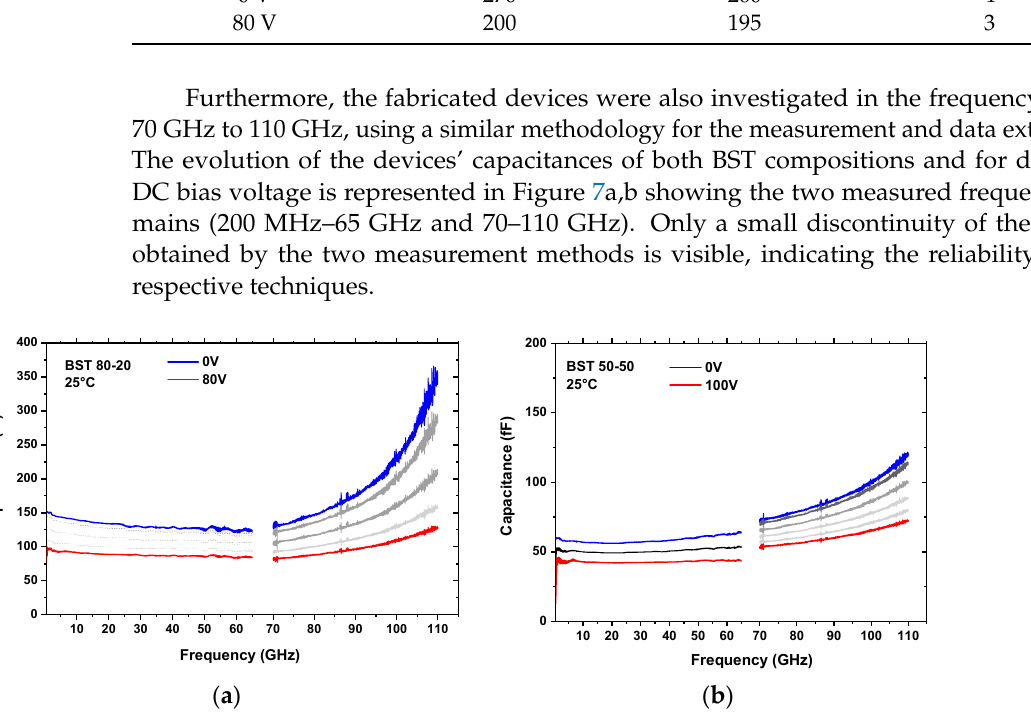
Figure 7. Capacitance values variation with applied bias for IDC devices integrating BST 80–20 ( a ) and BST 50–50 ( b ) thin films up to 110 GHz.